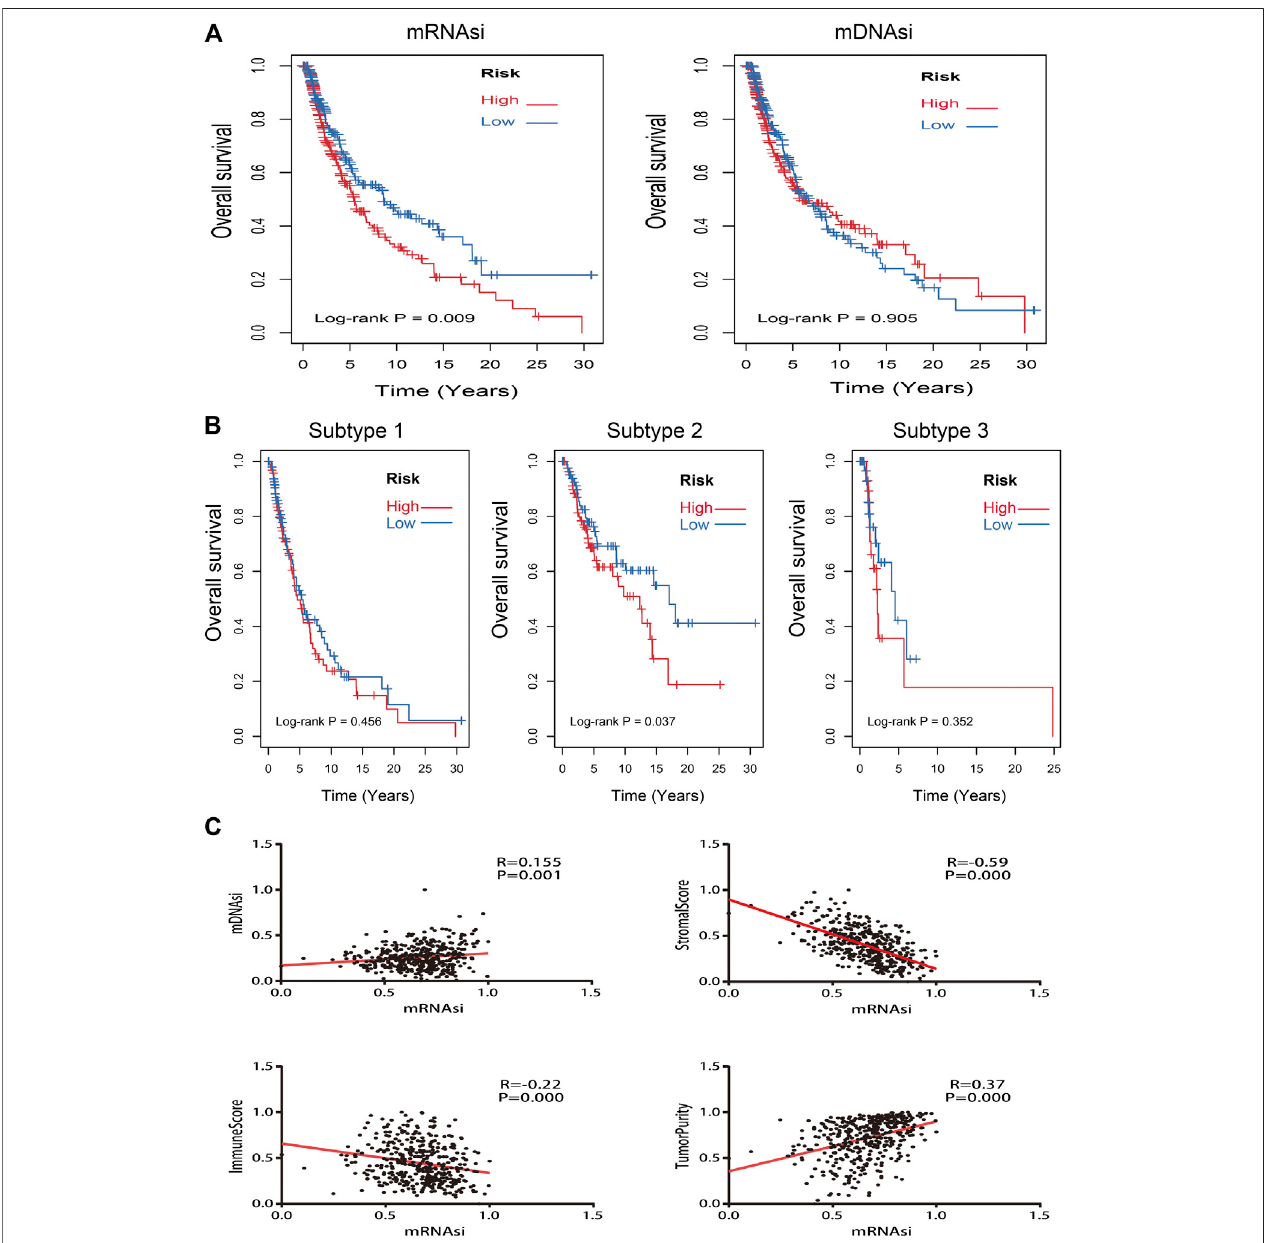
FIGURE 3 | Kaplan – Meier survival analysis and correlation analysis of stemness indices. (A) : Kaplan – Meier analysis of mRNAsi and mDNAsi in all melanoma samples; (B) : Kaplan – Meier analysis of each subtype of melanoma patients with high or low mRNAsi; (C) : the correlation analysis between mRNAsi and other indices (mDNAsi, immune score, stromal score, and tumor